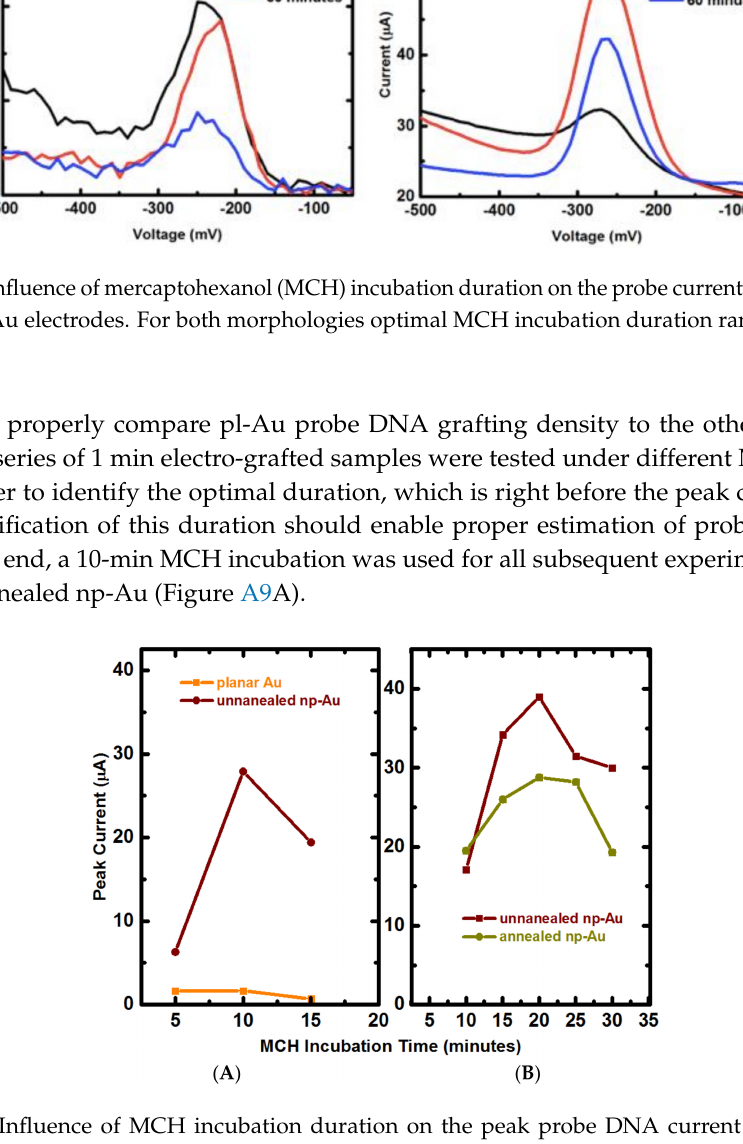
Figure A9. Influence of MCH incubation duration on the peak probe DNA current for different morphologies, where the incubation duration preceding the reduction in peak current indicates the optimal duration for comparing the amount of immobilized probe DNA on different electrode morphologies. ( A ) 10 min was identified as the optimal MCH incubation duration for comparing pl-Au and unannealed np-Au. ( B ) 20 min was the optimal MCH incubation duration for comparing unannealed np-Au and annealed